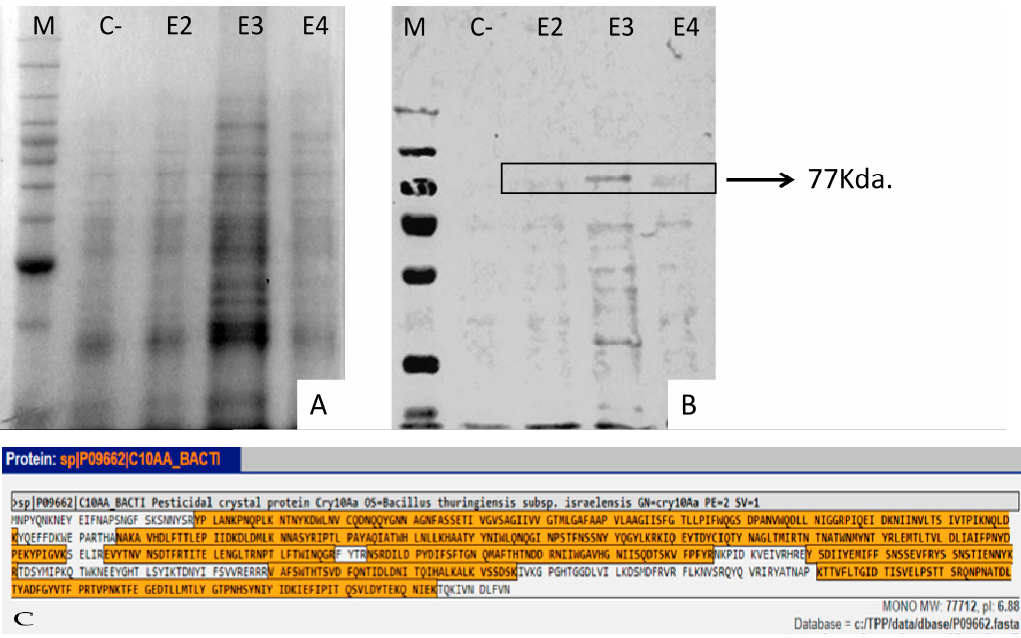
well, 10 μ g. Letters represent statistical significance (Student's t-test) between embryos and leaves from each transformation event.